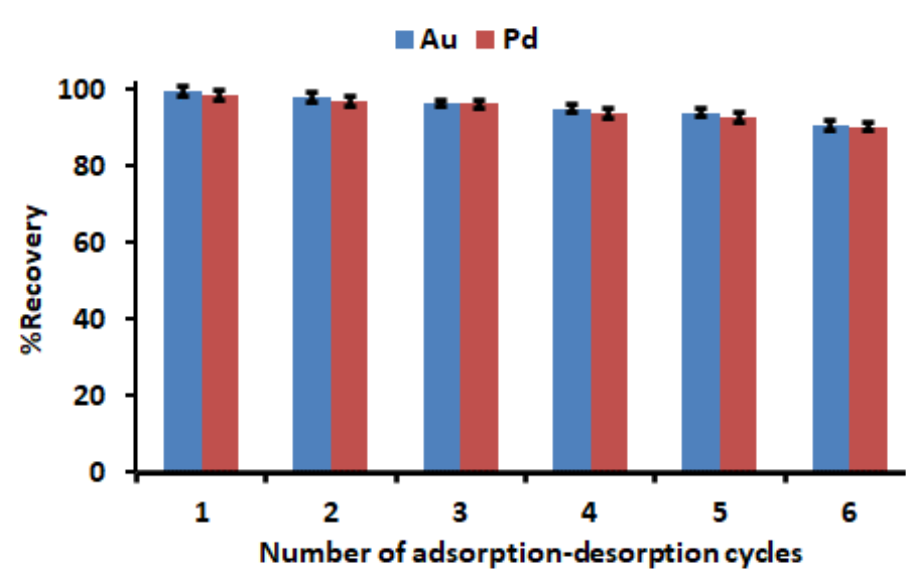
Figure 12. Regeneration and stability studies. Experimental conditions: mass of adsorbent, 150 mg; HNO 3 - HCl mixture at concentration, 2 mol L −1 ; initial concentration, 500 µg L −1 ; extraction time, 30 min; desorption time, 5 min; sample pH, 3.5; sample volume, 50 mL.